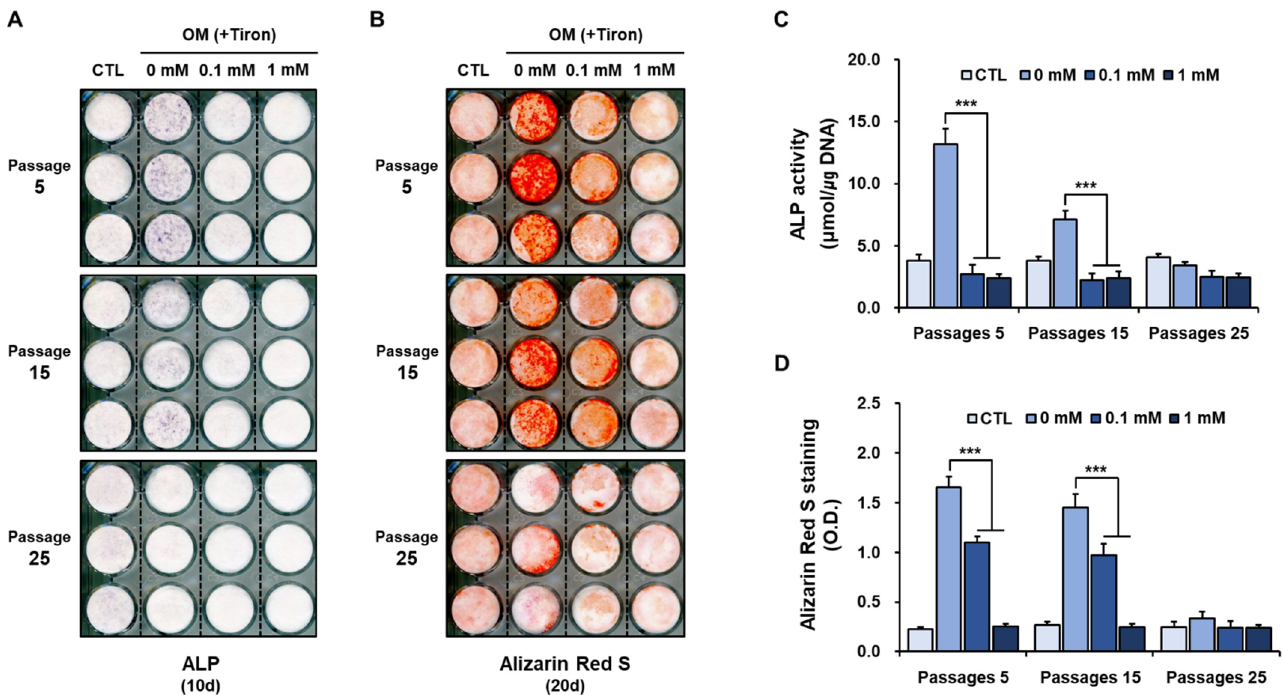
Figure 2. Effects of tiron on osteogenic phenotypes of hPDCs. Tiron reduced osteoblastic differenti- ation of hPDCs by reducing ( A , C ) ALP activity and ( B , D ) alizarin red-positive mineralization. CTL: DMEM; OM: osteogenic induction media. (*** p < 0.001) .